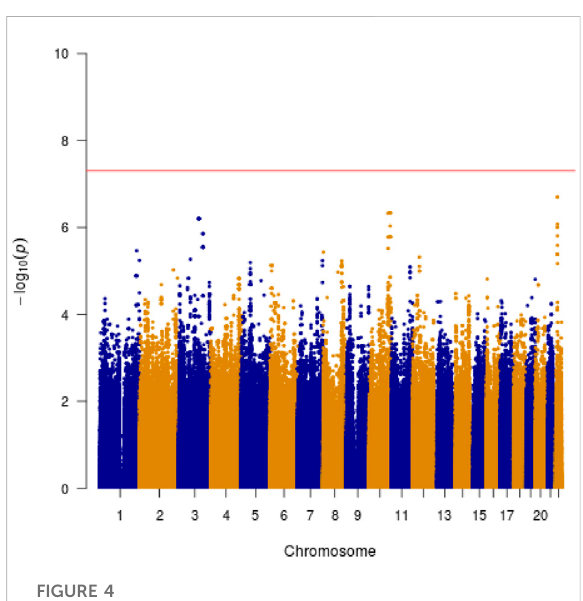
FIGURE 4 Manhattan plot showing genome-wide association analysis for